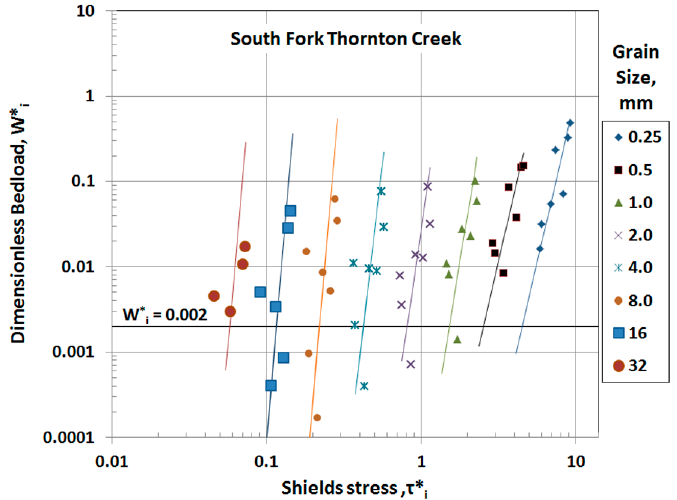
Figure 1. Size-specific transport rates. Log-log (power) regression lines are fit to the data for each grain size class to determine the size-specific reference Shields stress, τ ∗ crosses W ∗ = 0.002. Regressions are computed to minimize sum of squared distances between the i points and the regression line (orthogonal regression), except for the 32 mm line, which had too few points to accurately determine its slope. It was assigned a slope equal to the average of the 16 mm and 8 mm slopes, and was constrained to pass through the centroid of the data.